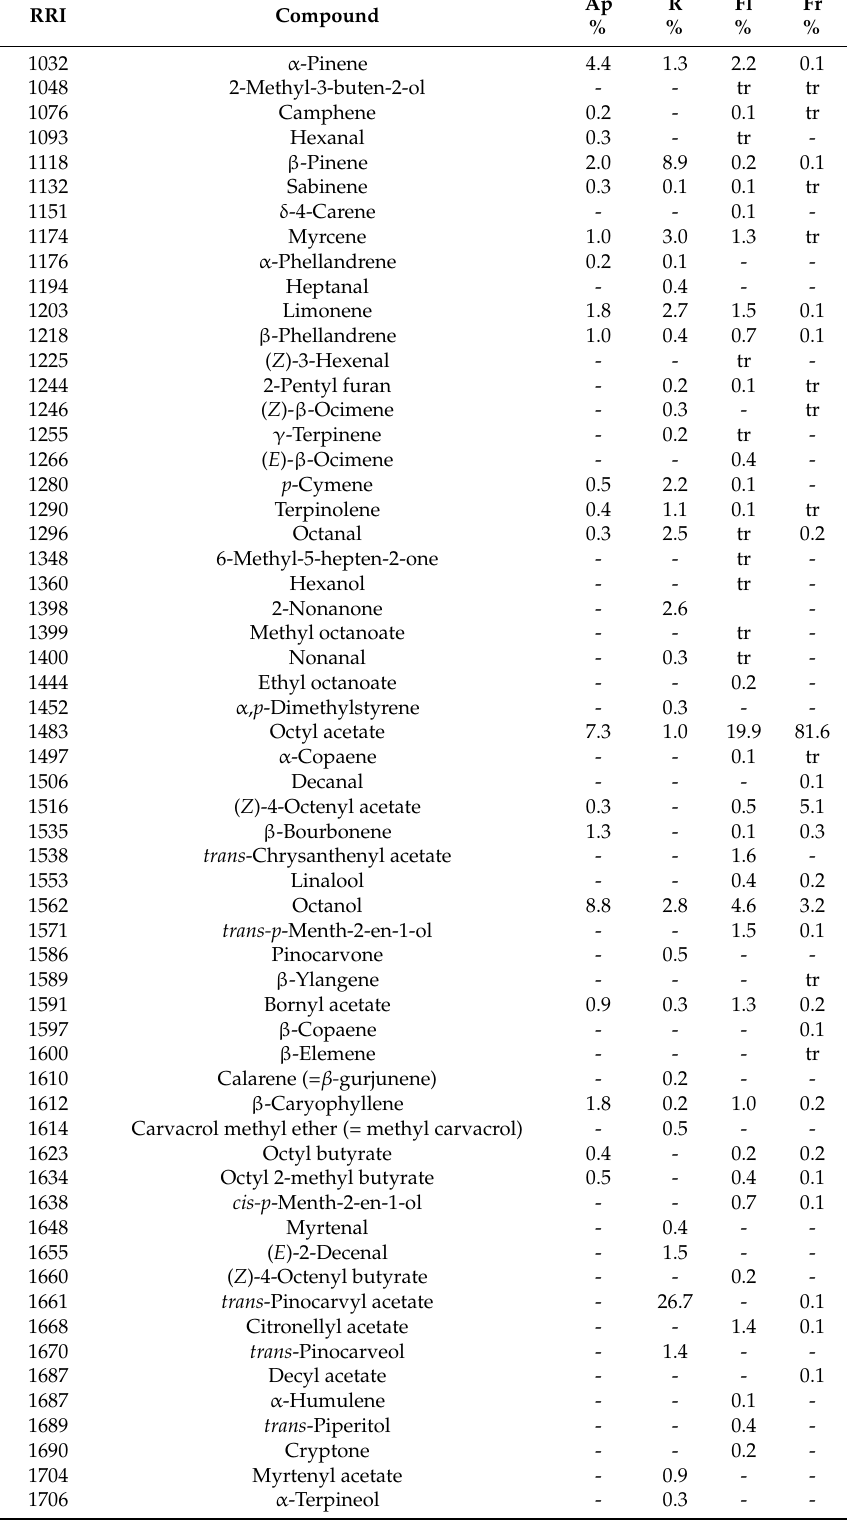
Table 4. The composition of the essential oils of Zosima absinthifolia